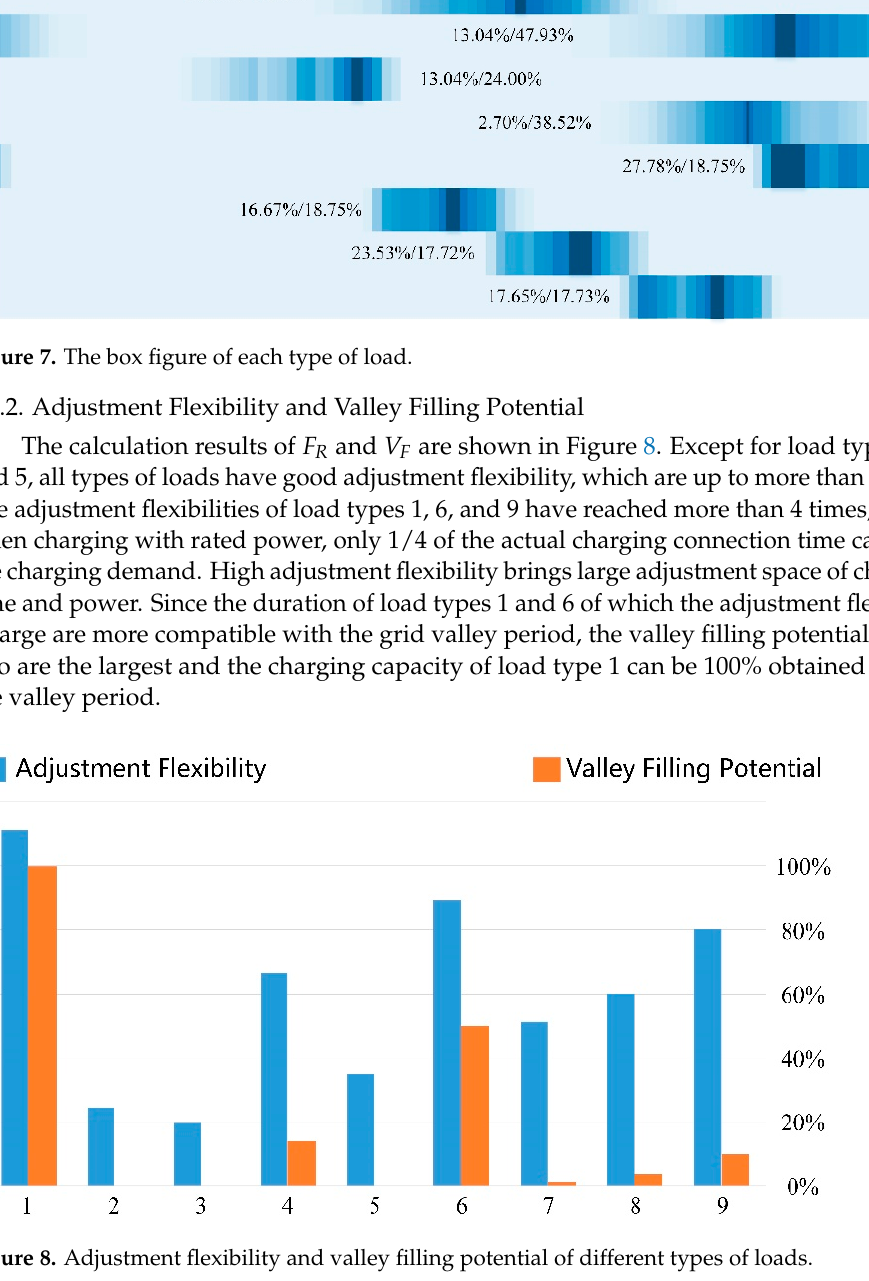
( c ) charging start time Figure 6. The box figure of each type of load. 4.2. Characteristics of Each Load Type 4.2.1. Peak Load Ratio and Daily Load Duration Ratio